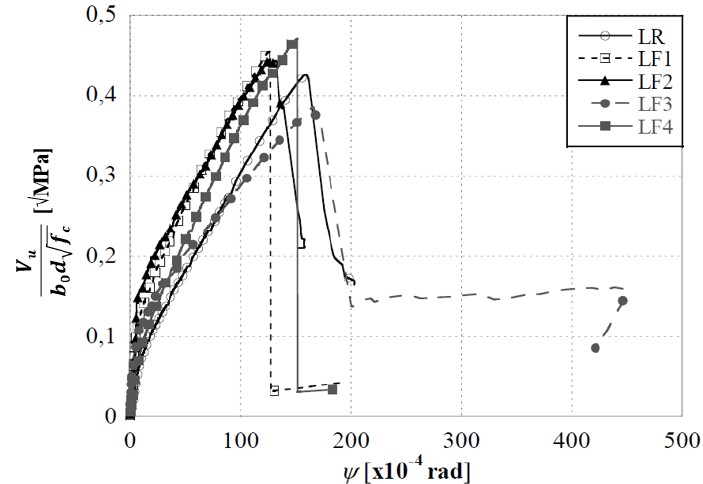
Figure 12. Load-rotation